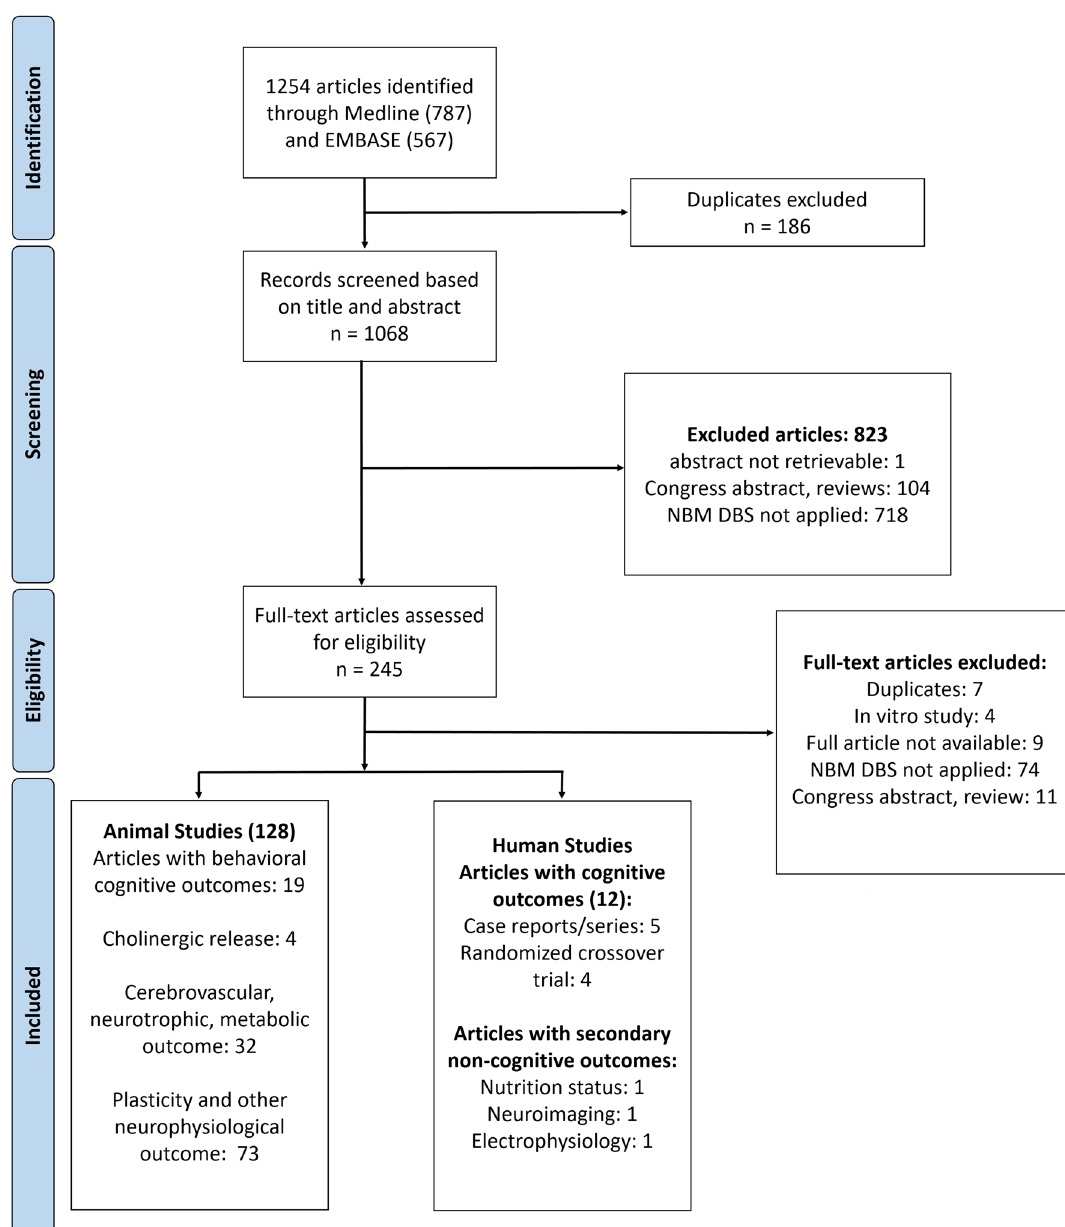
Figure 1. Diagram illustrating the search strategy of the systematic